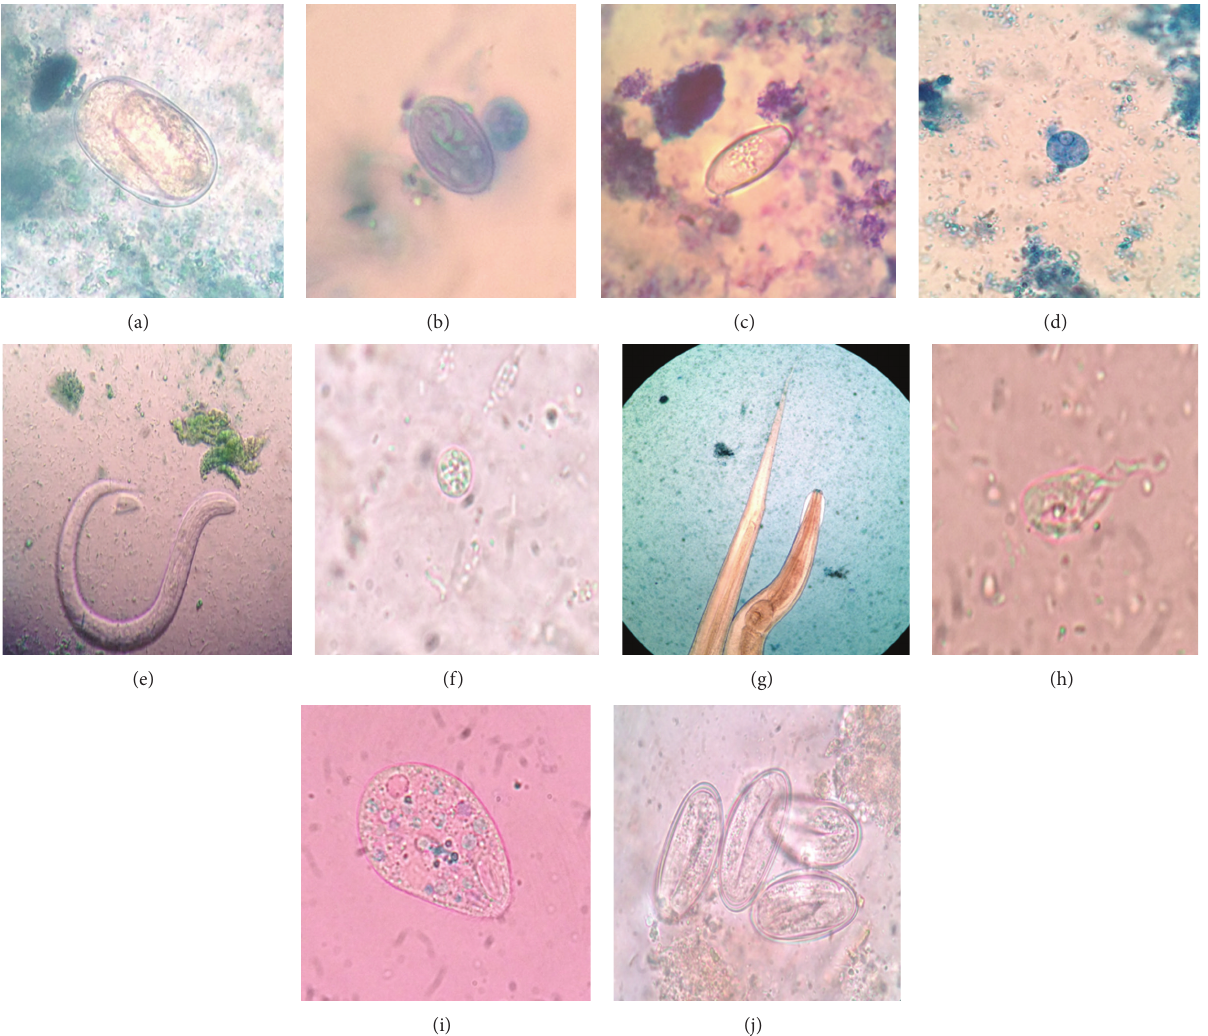
Figure 1: Hookworm ova (a), cyst of Giardia lamblia (b), oocyst of Isospora belli (c), trophozoites of E. histolytica (d), Strongyloides stercoralis larvae (e), oocyst of Cyclospora spp. (f), pinworm (g), trophozoite of Trichomonas vaginalis (h), Paramecium spp. (i), and eggs of Enterobius vermicularis (j) as seen on methylene blue-glycerol mount under microscope at 40x